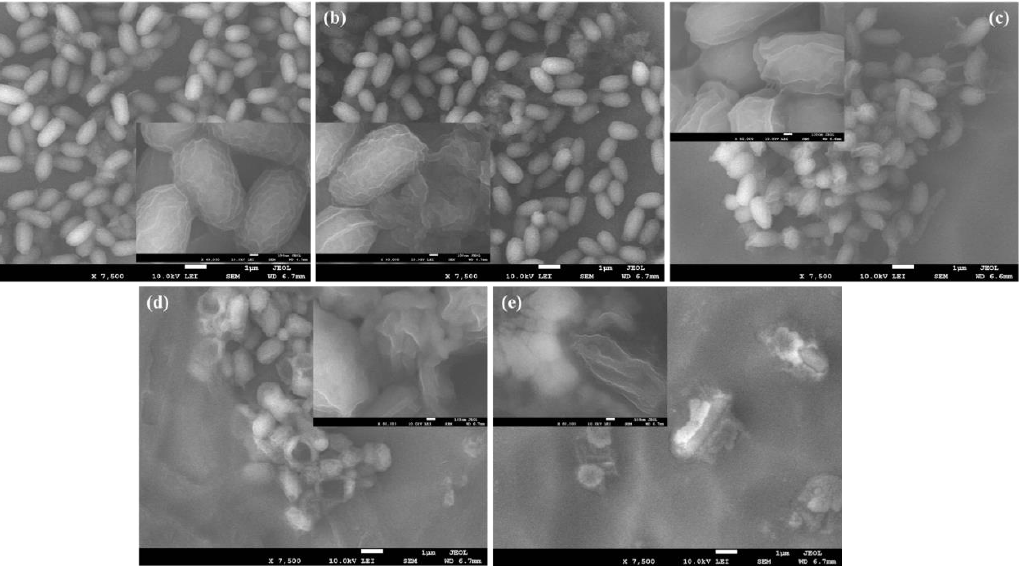
Figure 9. Scanning electron microscopy image of E. coli without any treatment as a control without an effect on cell morphology ( a ), and E. coli culture treated with GN ( b ), GN@CR ( c ), partial cell damage by the treatment of GN@Cu ( d ), and complete bacterial cell damage by the treatment of GN@CR-Cu ( e